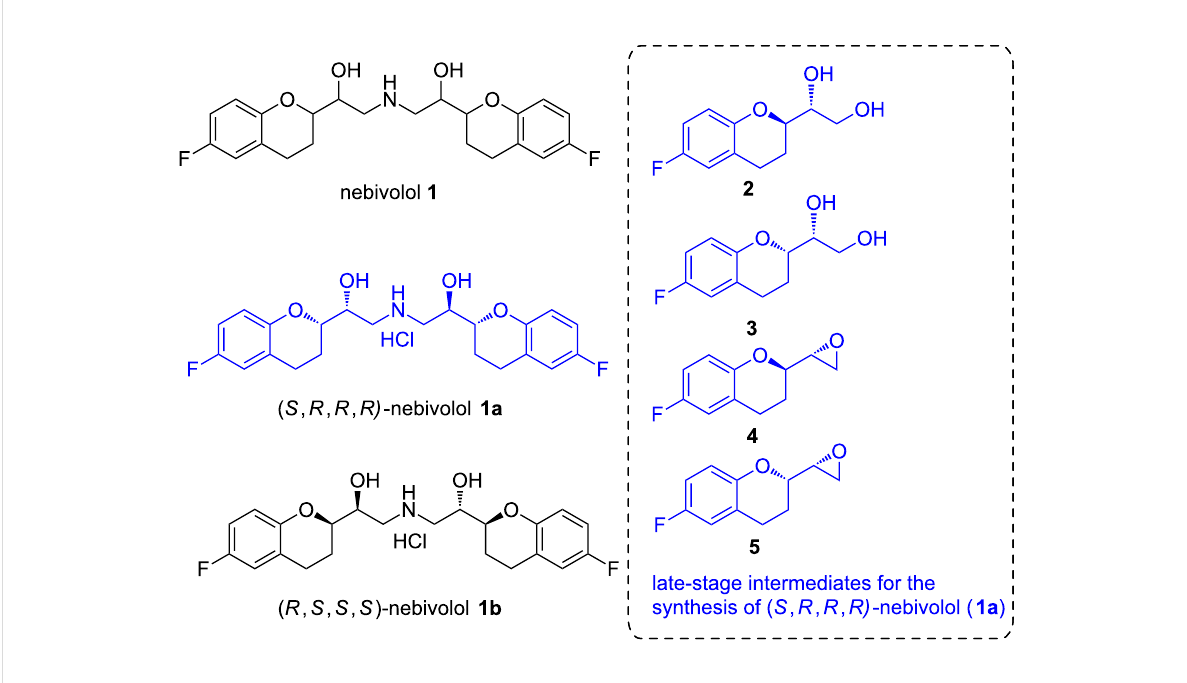
Figure 1: The chroman-based antihypertensive drug nebivolol, its biologically active stereoisomers and late-stage intermediates for its synthesis.